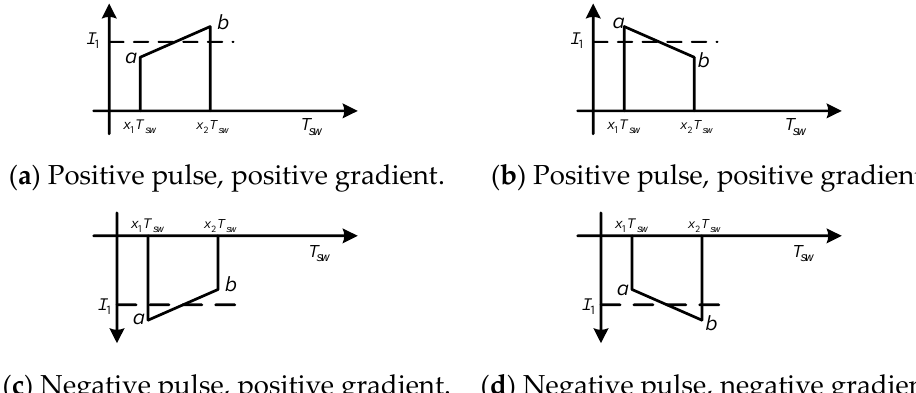
Figure 9. Generic current pulses .